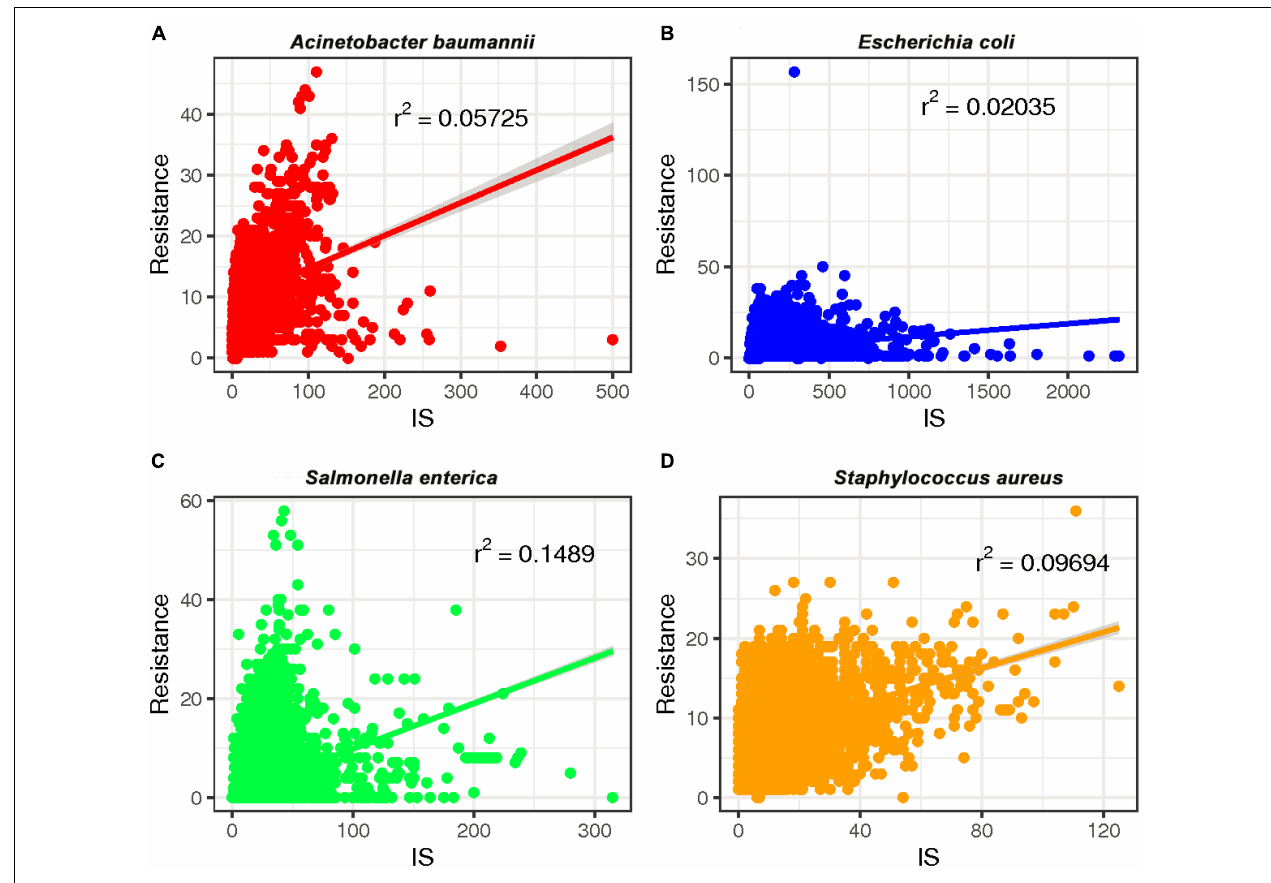
FIGURE 2 | The relationship between the number of drug-resistance genes (ARGs) and insertion sequences (IS) from four species: (A) A. baumannii , (B) E. coli , (C) S. enterica , and (D) S. aureus . The number of ARGs and ISs of each sample were extracted from the results of the BacAnt analysis, and the number was plotted as the horizontal and vertical coordinates, respectively. The scatter plot was created using the ggplot2 package in R (V3.6.2), and a trend line generated.